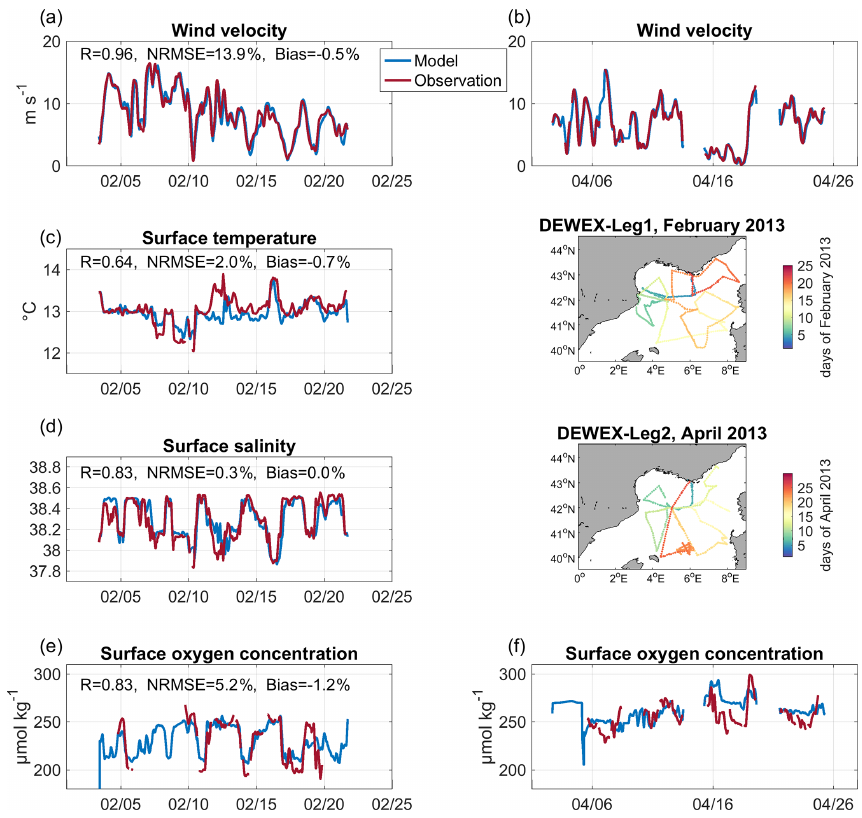
Figure 2. Time evolution during DEWEX Leg1 (in February 2013, a , c , d and e ) and Leg2 (in April 2013, b, f ) cruises of observed (red) and modelled (blue) ( a and b ) wind velocity (ms − 1 ), (c) surface temperature ( ◦ C), (d) surface salinity, and (e, f) surface dissolved oxygen concentration (µmolkg − 1 ). Trajectories of the measurements during DEWEX Leg1 and Leg2 cruises are indicated on inserted maps. Modelled wind velocity was provided by ECMWF. No surface temperature and salinity data are available over the period of DEWEX Leg2. The metrics indicated for the modelled wind velocity and surface oxygen concentration were calculated for both DEWEX Leg1 and Leg2